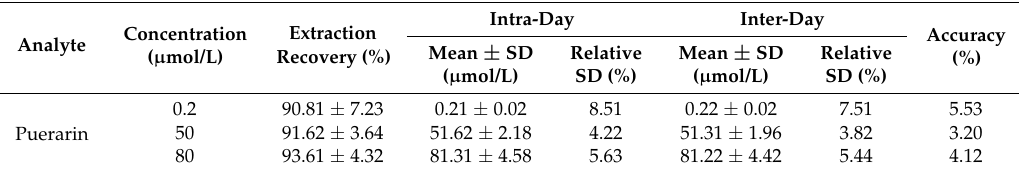
Table 3. Stability of puerarin in rat plasma samples ( n = 3).